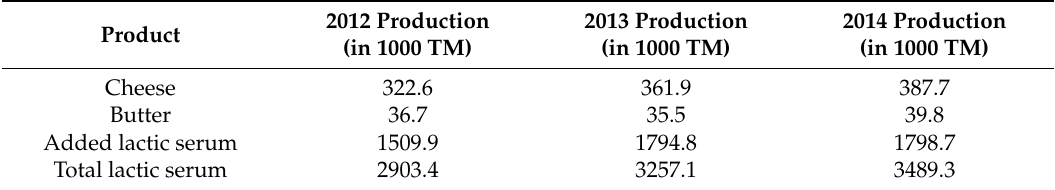
Table 1. Lactic serum production [19].